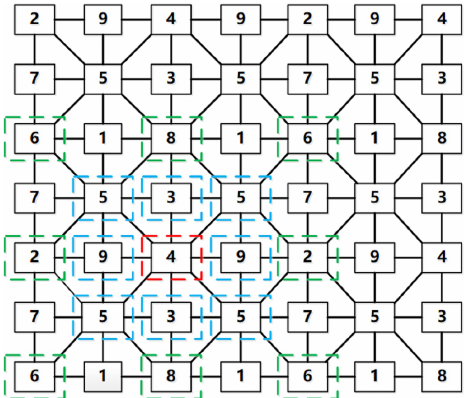
Figure 13. 7 × 7 visual reference topological structure diagram of UAV formation.